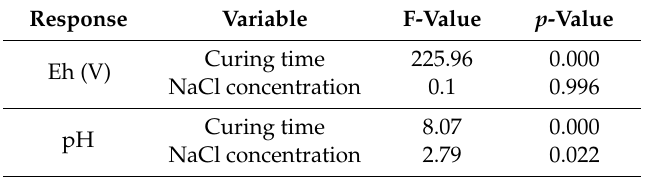
Table 4. ANOVA of the e ff ects of cure time and NaCl concentration on system potential and pH.